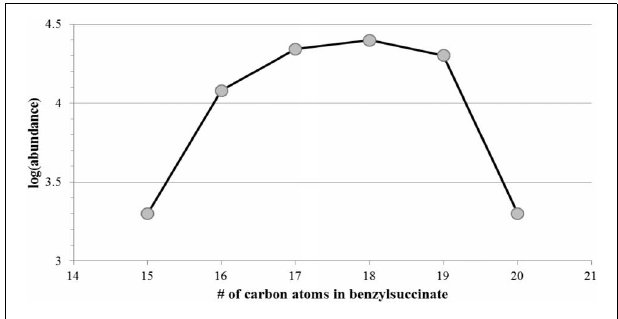
FIGURE 7 | Neighbor-joining dendrogram of assA clone sequences obtained from GoM sediments (GoM278 – red; GoM315 – blue) compared to assA / masD sequences of reference strains and BLAST matches. The tree was constructed using theTajima–Nei distance method